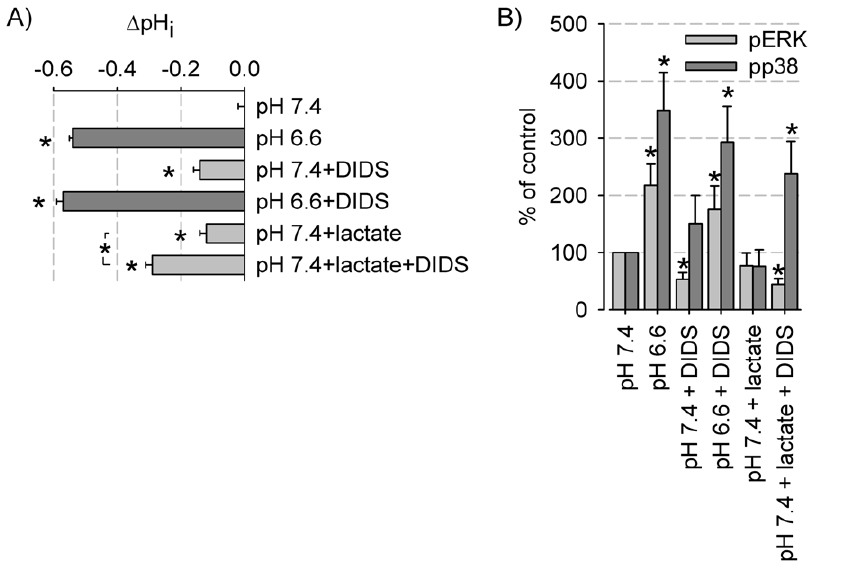
Figure 4. Impact of blocking bicarbonate transport on intracellular pH-regulation and MAPK phosphorylation. (A) Long term effects (3 h) of exposure to DIDS (200 m M) and/or addition of 40 mM lactate (N=14–56) on pH i . pH-changes are compared to control conditions (pH 7.4) (*) p , 0.05. (B) Ratio of phosphorylated MAPK/overall protein as % of control (pH 7.4); N=3–7 for pERK; N=4–9 for phospho-p38; (*) p , 0.05.